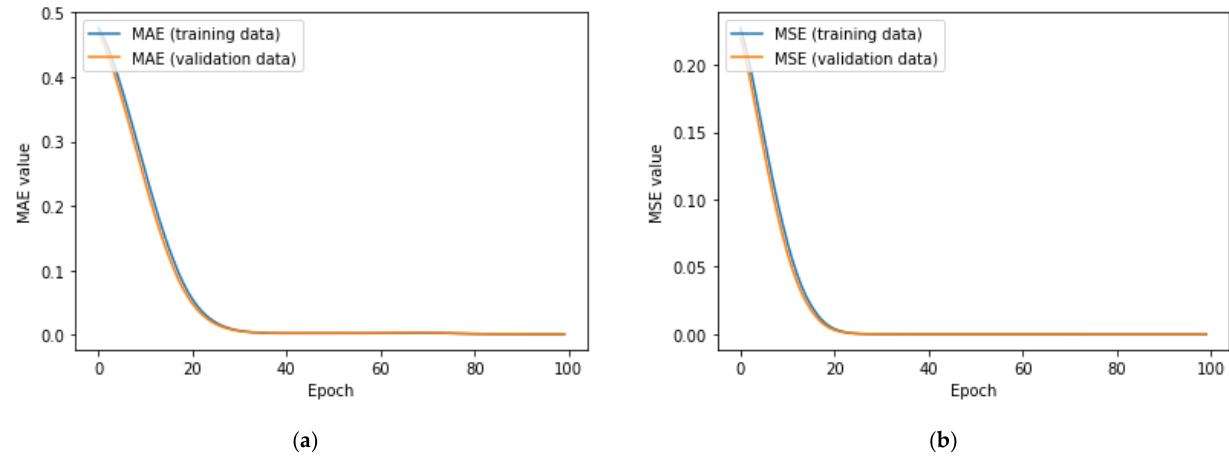
Figure 4. Neural network performance plots. ( a ) Mean absolute error and ( b ) mean square error plots during ANN training for training and validation data.